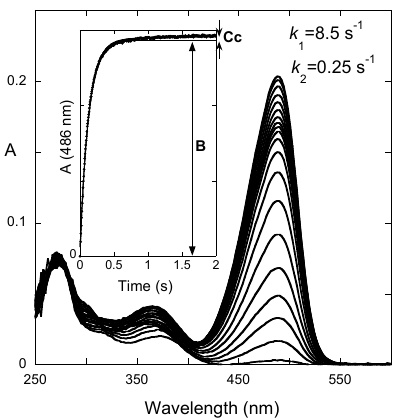
Figure 6. Spectral variations upon a reverse pH jump of the compound 4 ′ ,7-dihydroxy-3- methoxyflavylium 7.5 × 10 − 6 M, from equilibrated solutions at pH = 6 to 1, K t = 0.05. With permission from RSC, ref. [15].